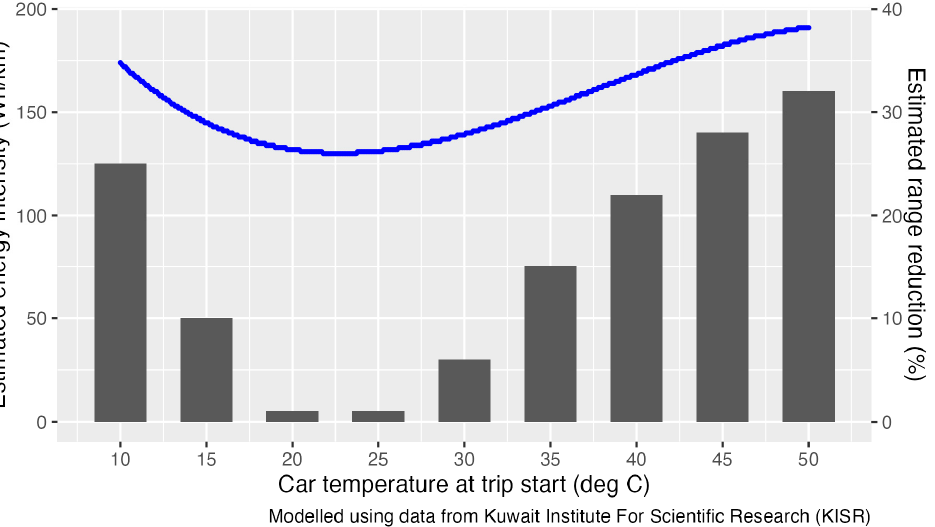
Figure 7. Modelled in-use energy intensity (blue line, left axis) and range reduction (grey columns, right axis) by car temperature at start of journey.